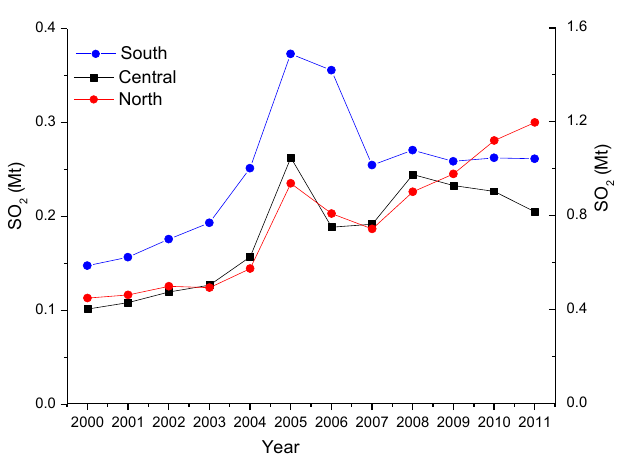
Figure 4. Spatial variations of total SO 2 emissions of manufacturing in Jiangsu province during 2000–2011.